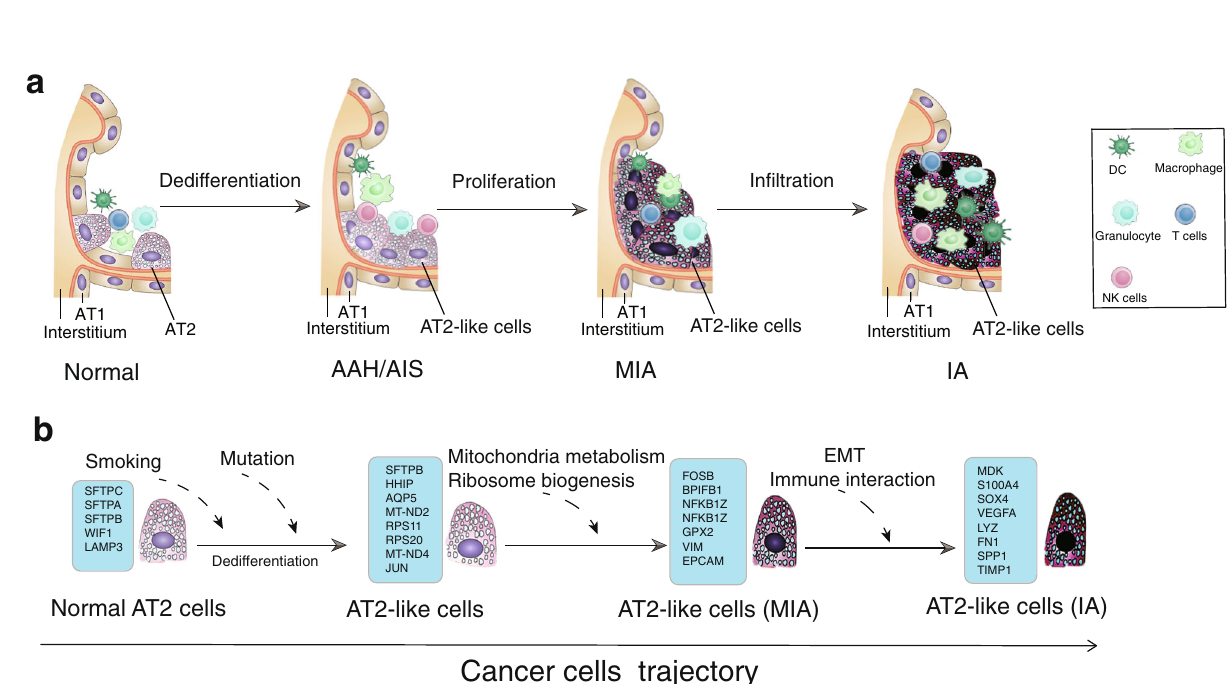
Fig. 5 Cell – cell crosstalk during LUAD progression. a Heat map depicting the signi fi cant interactions among the 16 major cell types identi fi ed in Fig. 1b. b Overview of the selected ligand-receptor interactions. p -values (two-tailed permutation test) are indicated by circle size; the scale is on the right. The means of the average expression level of interacting molecule 1 in cluster 1 and interacting molecule 2 in cluster 2 are indicated by color. Assays were carried out at the RNA level, but extrapolated to protein interactions. Selected cells include AT2 cells, AT2-like cells, ECs and fi broblasts. AT2: alveolar type 2 cells; ECs: endothelial cells. c Diagram of the main receptors and ligands expressed on AT2 cells and AT2-like cells, AT1: alveolar type 1 cells; AT2: alveolar type 2 cells. d Representative multiplexed staining of cytokeratin-positive tumor cells (Cyan), CD68 + macrophages (orange), FoxP3 + regulatory T cells (yellow), CD8 + T cells (red), PD-1 + cells (magenta), and PD-L1 + cells (green) on tissues from different stages. Each staining in panels come from three samples. Scale 50 μ m, nuclei (DAPI) are stained blue.